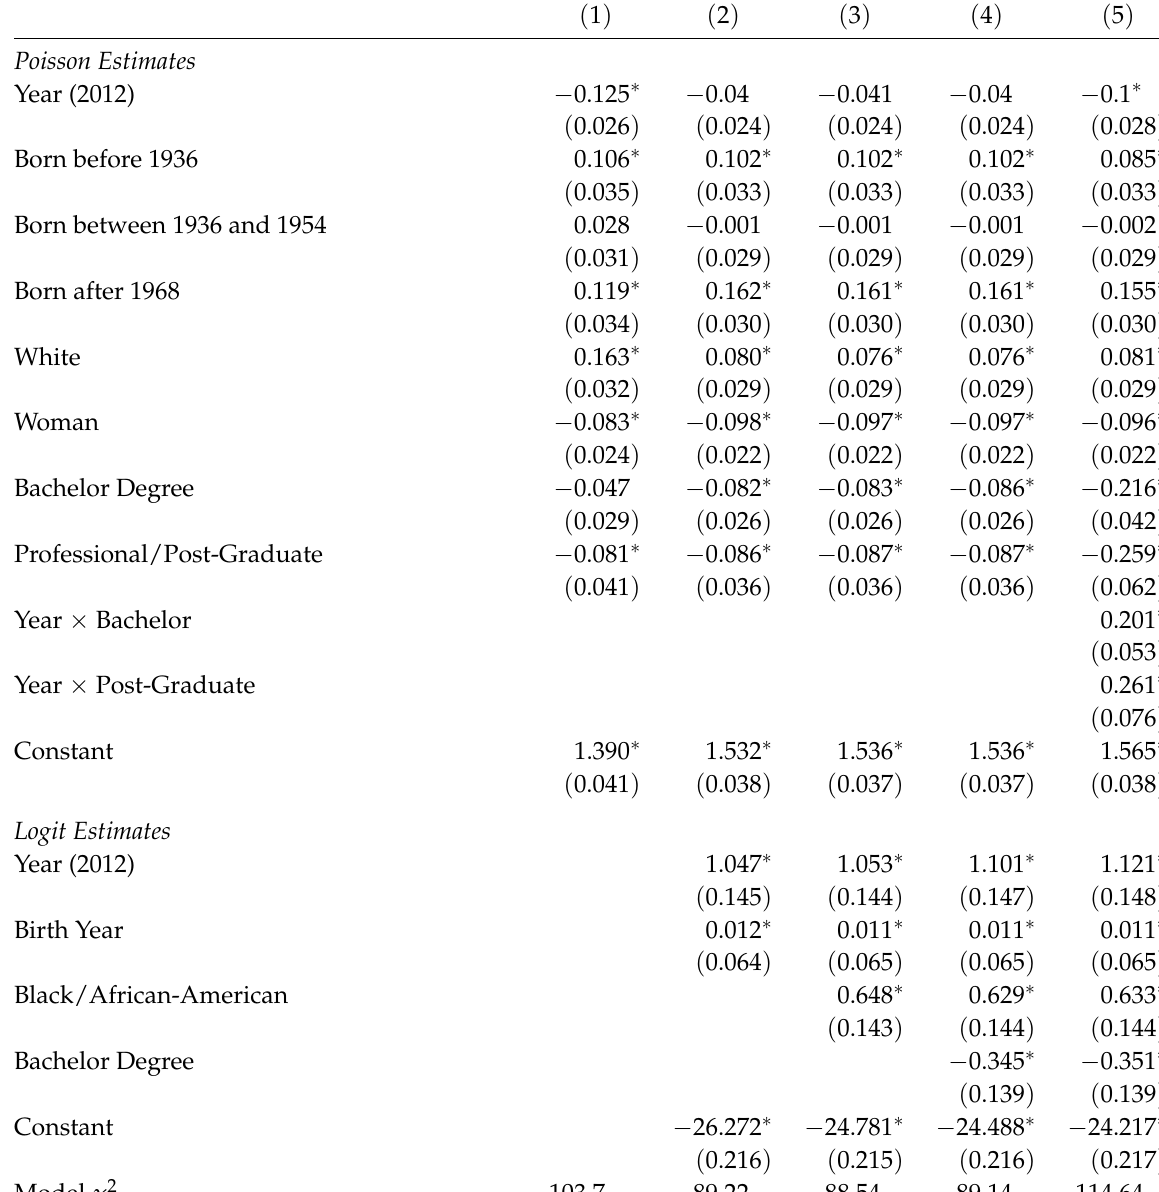
Table 3: Coefficient Estimates of robust Zero-Inflated Poisson models predicting the number of dislikes in the pooled 1993 GSS and 2012 SSI surveys. Poisson count model estimates are shown in the top-half and binary logit model estimates in the bottom-half. (N =